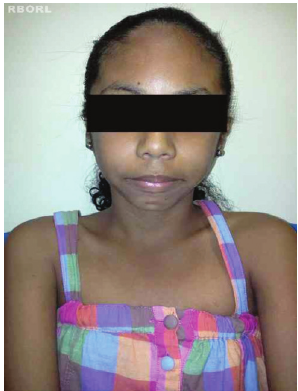
Figure 1 Frontal view of a patient with turner’s syndrome.